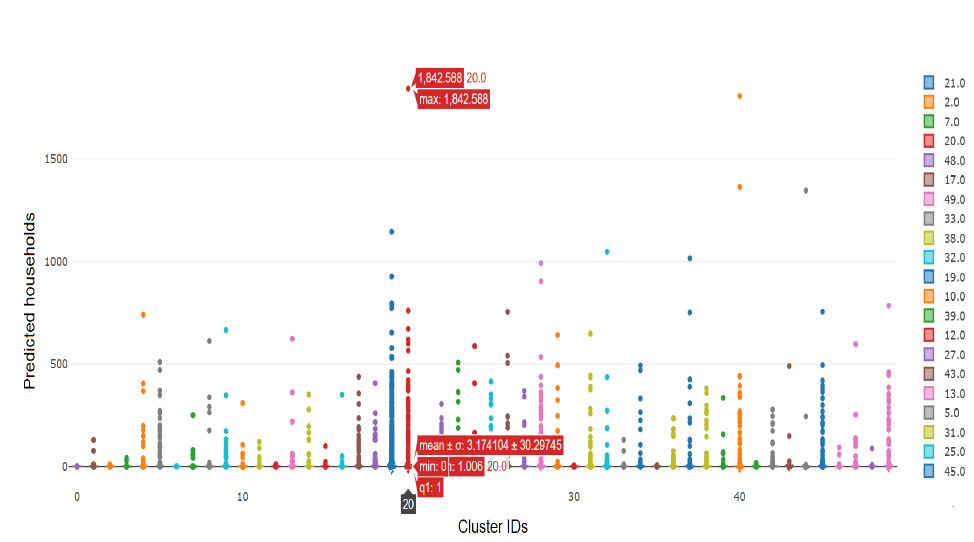
Figure 20. Mean and standard deviation plot to signify the K-means cluster IDs associated to the predicted households for year